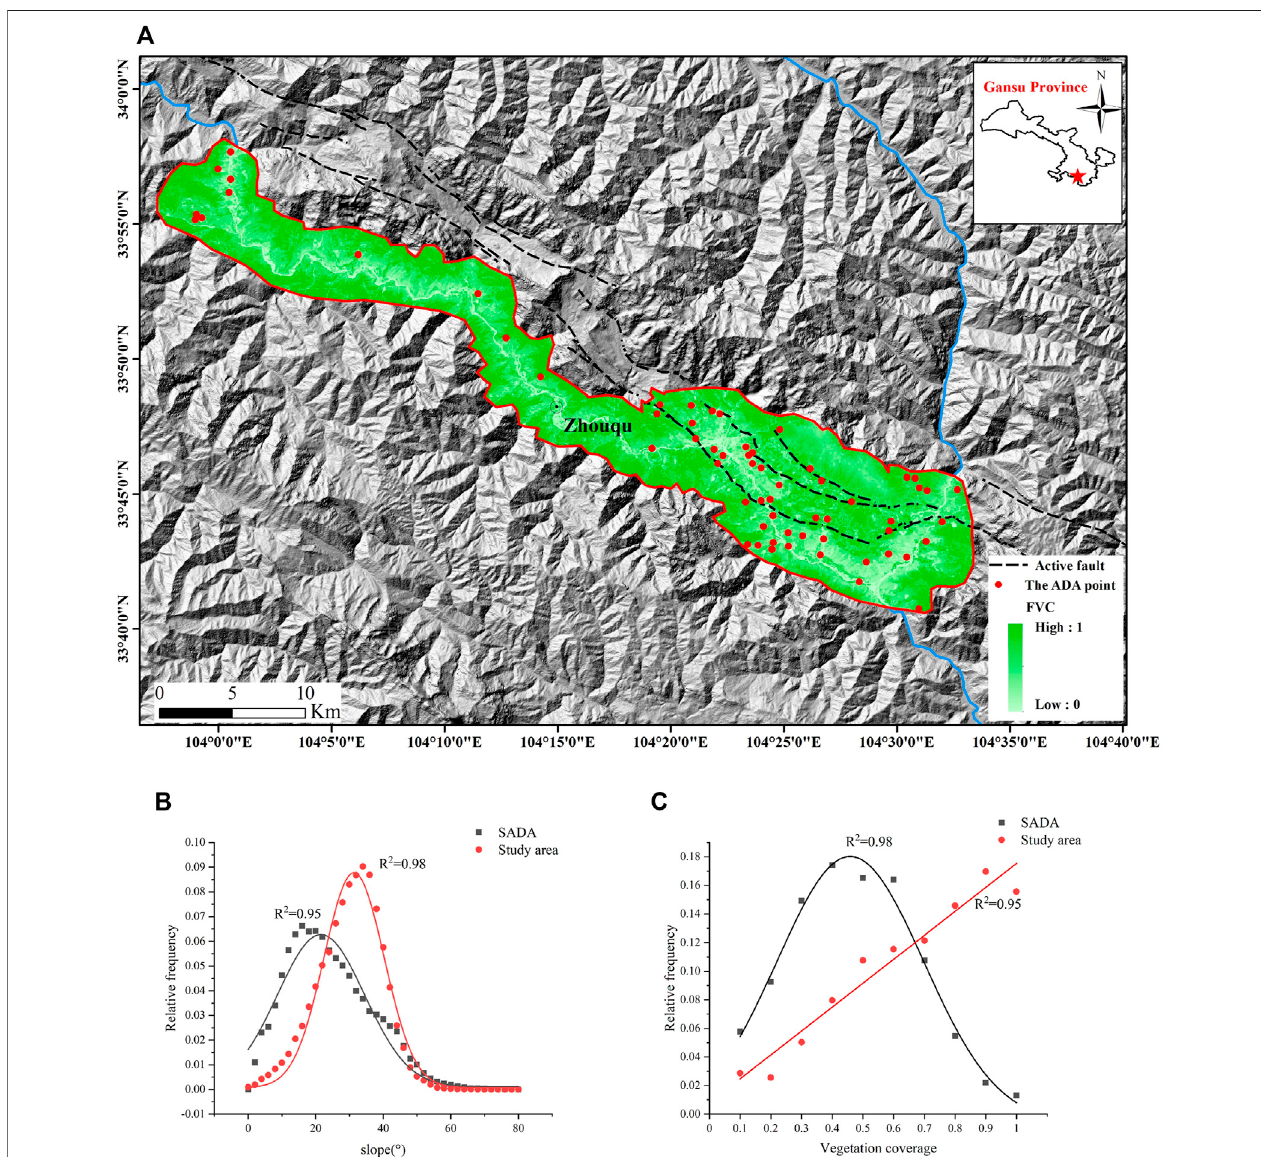
FIGURE14| Factorsin fl uencing landslides. (A) Vegetation coverage and faultdistributionmapofstudyarea, (B) relativefrequencydistributions ofslopeangle, (C) relative frequency distributions of vegetation coverage.